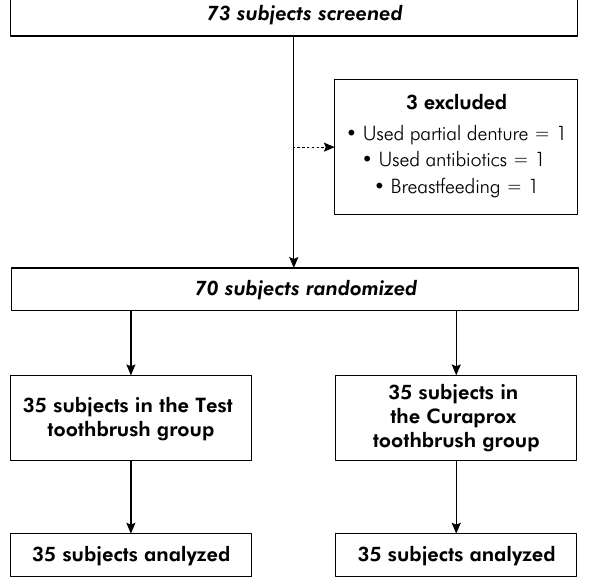
Figure 1. Flow chart of the